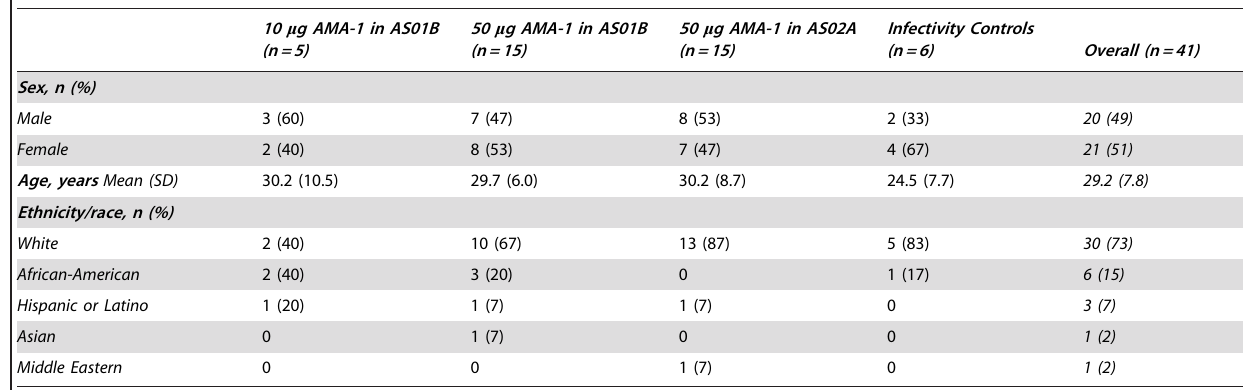
Table 1. Study volunteer